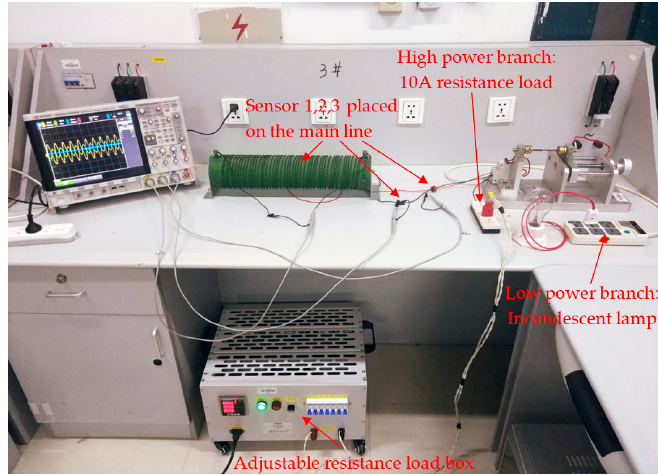
Figure 25. High-power shielding load experimental system.